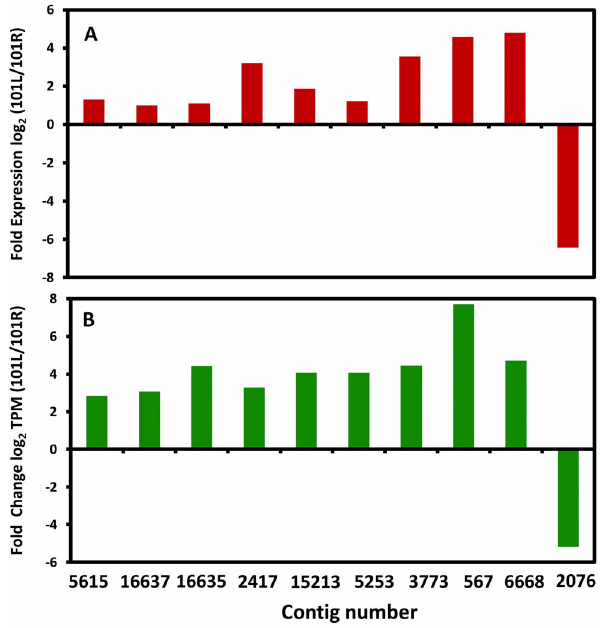
Figure 7. Validation of differentially expressed CYP450 genes in 101L and 101R. Quantitative Real time PCR (A) of selected differentially expressed CYP450s was carried out using total RNA isolated from leaf and root tissues. Digital gene expression (B) of CYP450s used for validating through quantitative Real time PCR.